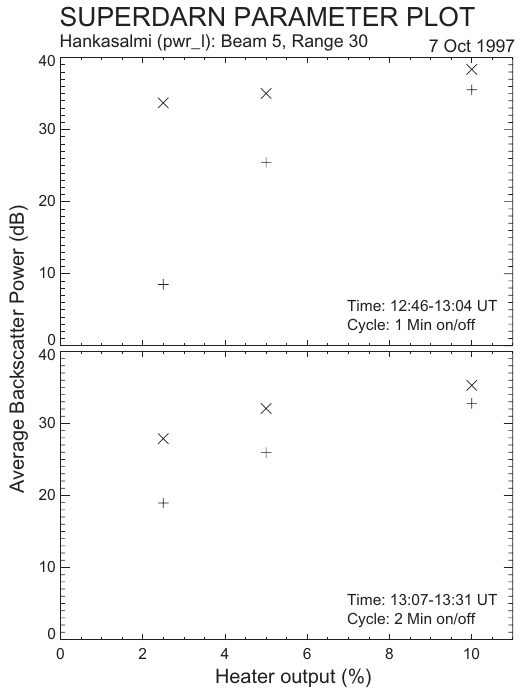
Fig. 9. The difference in average backscatter power received by the Hankasalmi radar as a function of heater output when the iono- sphere is (x) and is not (+) pre-conditioned by a preceding high power pulse from the heater. The upper (lower) panel shows data from 1 (2)-min on, 1 (2)-min off heater cycles.